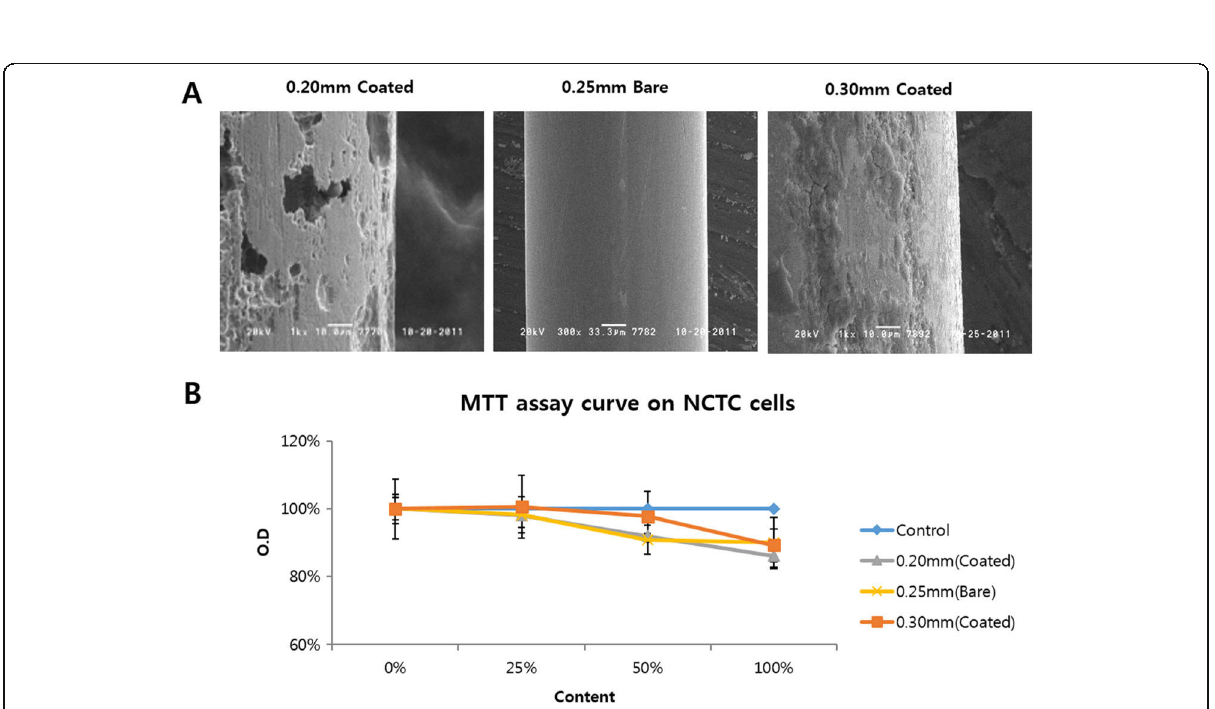
Fig. 6 Cytotoxicity of EA byproducts in NCTC cells. a : Needles used in the cytotoxicity experiments. Corrosion was not observed in non-coated 0.25-mm STS316 needles but was found in coated 0.2- and 0.3-mm STS316 needles. b : MTT assay in NCTC cells. Although the difference was not statistically significant, approximately 10% cytotoxicity was observed 100% media that had been subjected to electrical stimulation with the needle was applied to the